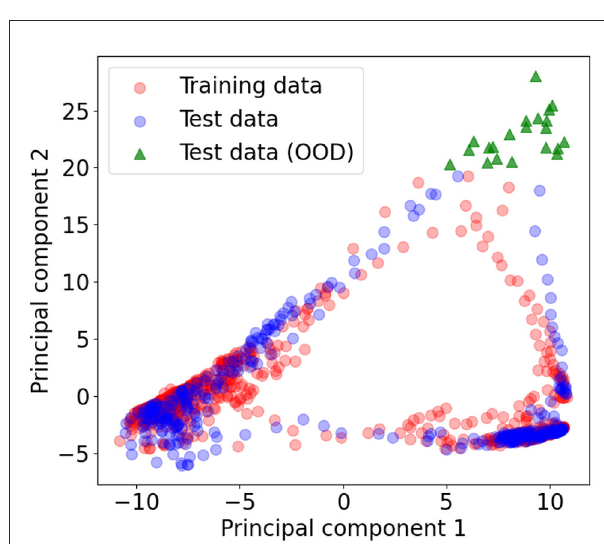
FIGURE5 Projecting the training and test data of the input hidden state variable ( h t ) from its original 128 dimensions to the 2-dimensional space using principal component analysis for visualization. The 21 points (highlighted in green triangles) of the test data are identified as OOD samples, which suggests that their predicted streamflow cannot be trusted. These streamflow predictions are located between the two green dashed lines in Figure 4B which indeed shows poor prediction accuracy.